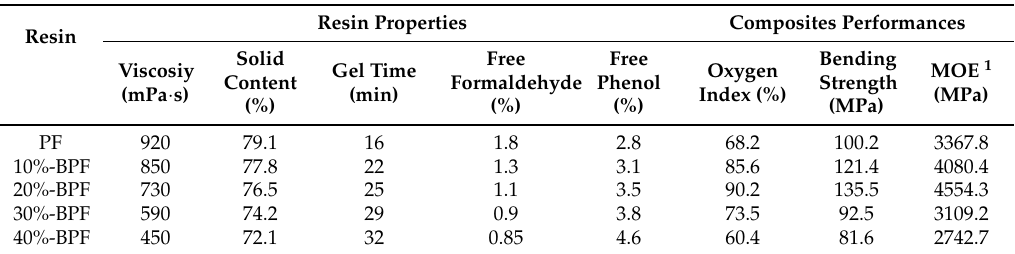
Table 1. Properties and glass fiber bio-oil phenol formaldehyde (GF/BPF) composites performances of BPF